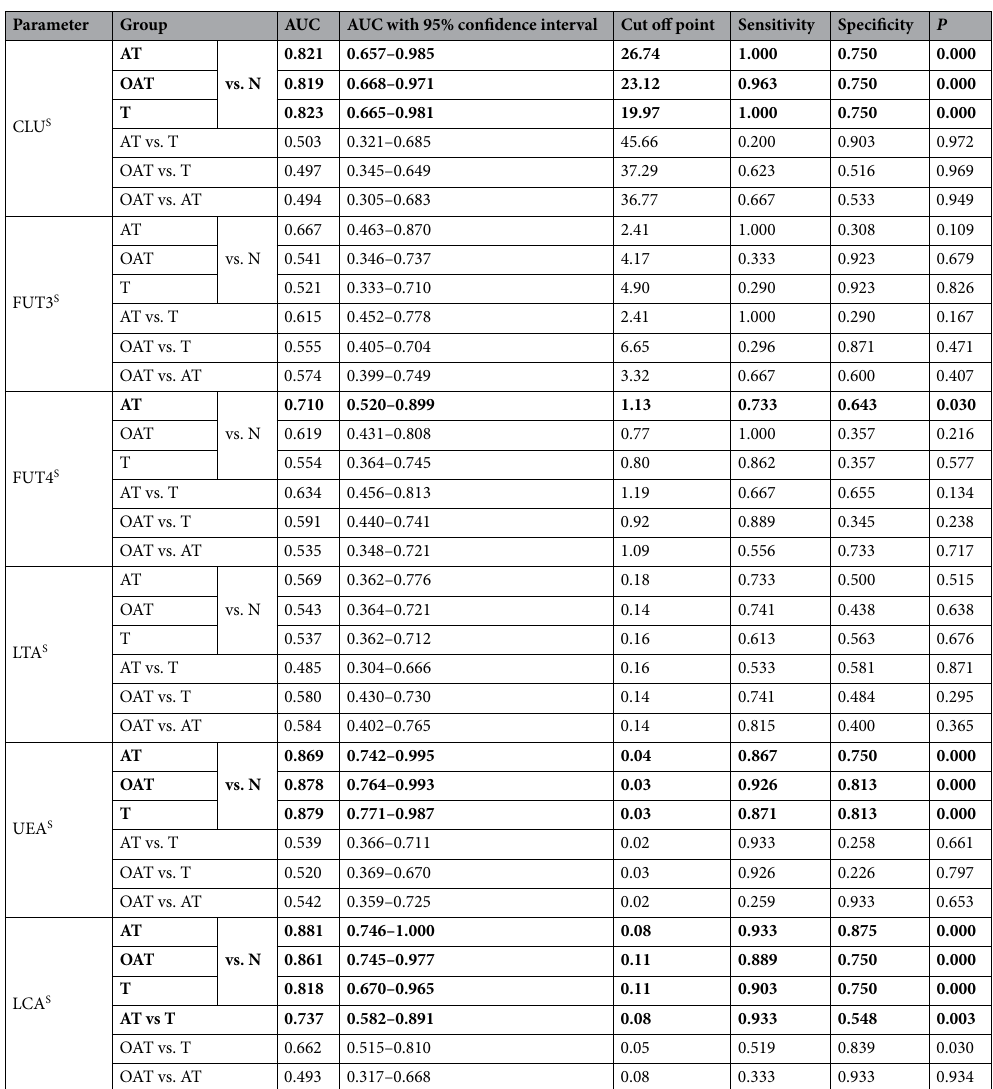
Table 4. Summary of receiver operating characteristic (ROC) curves for serum parameters. CLU S —serum CLU concentration; FUT3 S —serum FUT3 concentration; FUT4 S —serum FUT4 concentration; LTA S —relatsive reactivity of serum CLU glycans with Lotus tetragonolobus agglutinin; UEA S —relative reactivity of serum CLU glycans with Ulex europaeus agglutinin; LCA S —relative reactivity of serum CLU glycans with Lens culinaris agglutinin. Area under the ROC curve (AUC) is given with 95% confidence interval. Data with AUC equal or greater than 0.710 are marked in bold. Based on the AUC, the clinical value of laboratory test can be